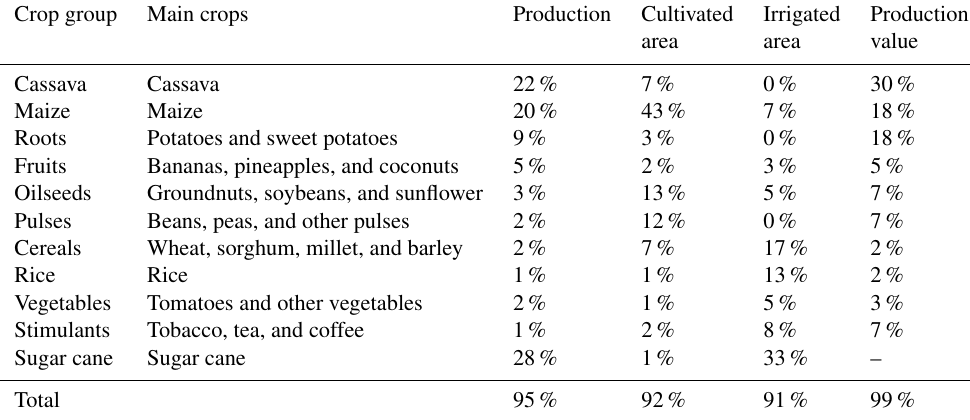
Table 1. Represented crops and their importance in the agricultural sector. The modelled crops represent more than 90% of the crop produc- tion, cultivated and irrigated area, and of the production value. The production value excludes meat and dairy products. Some crops have a moderate impact on the global economy (e.g. cereals, rice, and stimulants) but are important for irrigated agriculture. The share of irrigated area is taken from World Bank (2010), other indicators are taken from FAO (2018) averaged over the period from 2010 to 2016. Crop